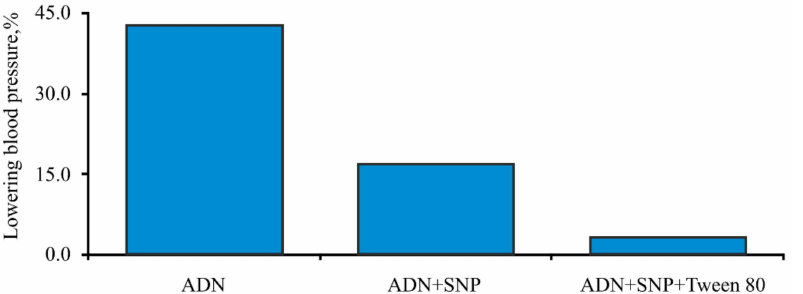
Figure 12. Hemodynamic effects of adenosine (ADN).